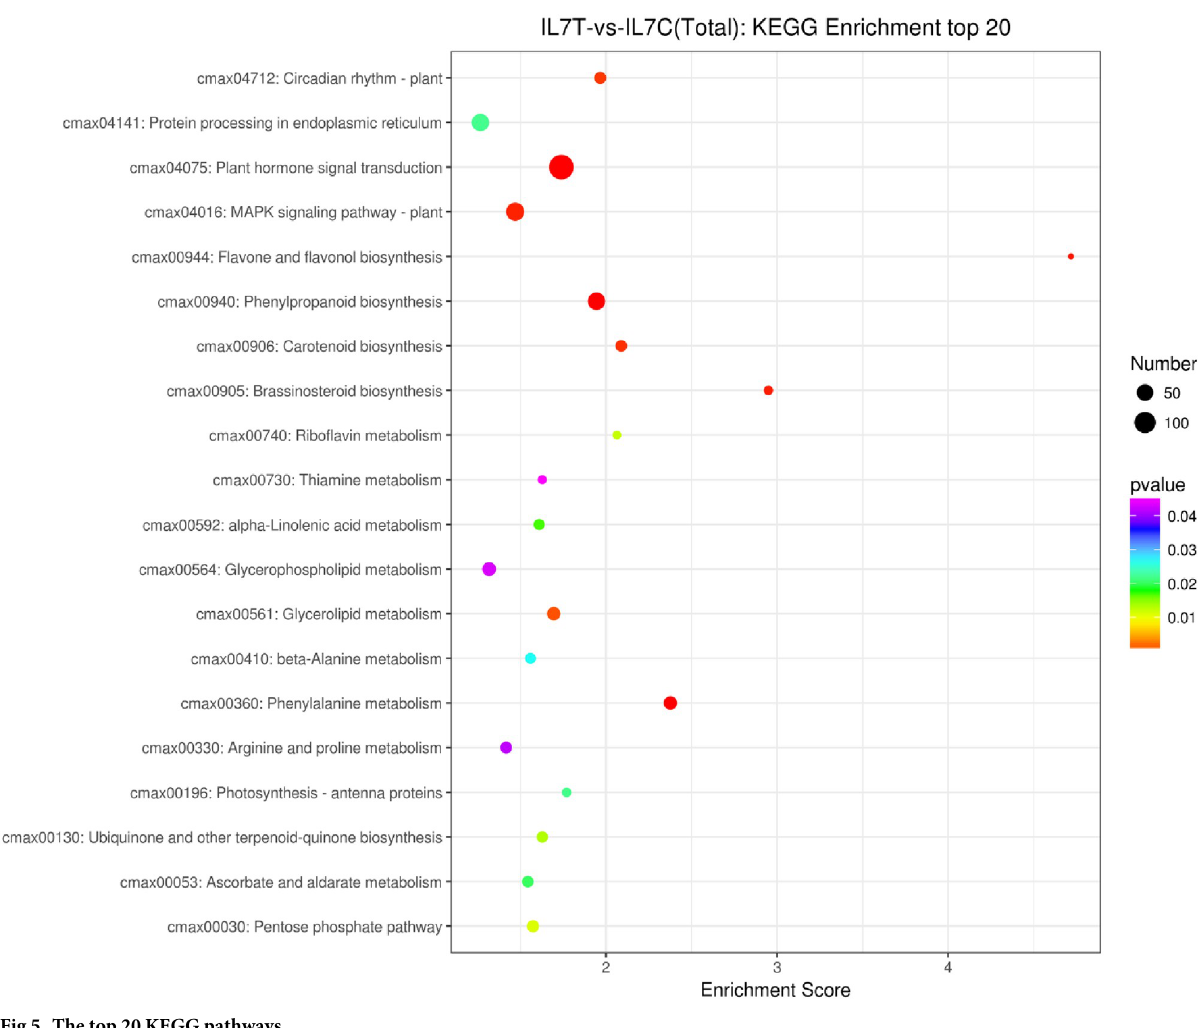
Fig 5. The top 20 KEGG